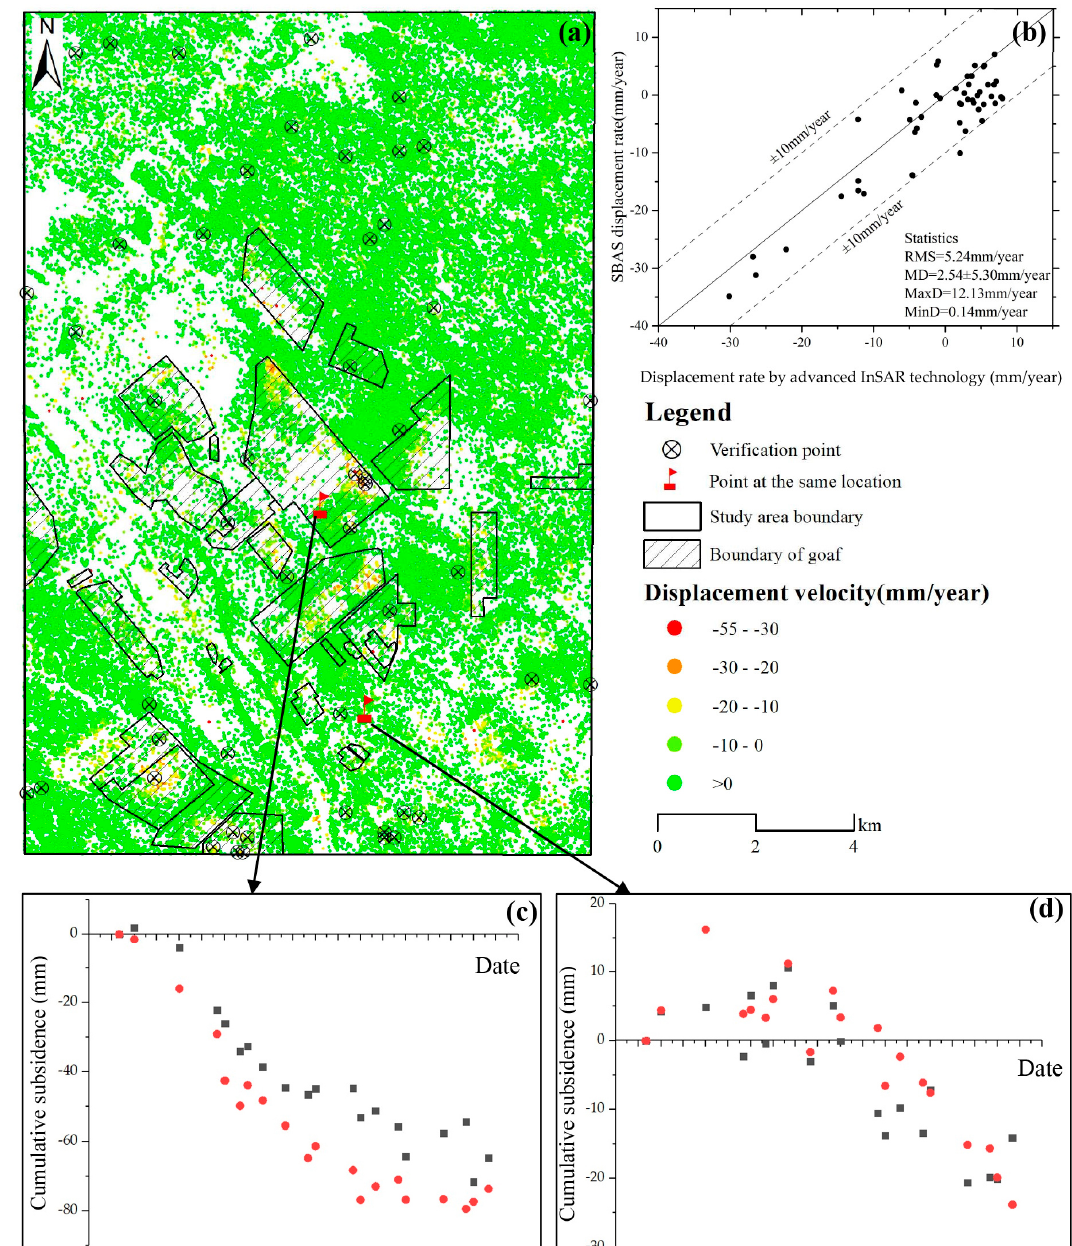
Figure 4. ( a ) Time-series InSAR result from 2006 to 2011 combined with distributed scatterers and persistent scatterers; ( b ) the comparison of land subsidence by two InSAR techniques; ( c , d ) cumulative displacement at the same location obtained by two approaches. Red dot represents SBAS-InSAR result and the black square represents the InSAR result which combined with distributed scatterers and persistent scatterers.